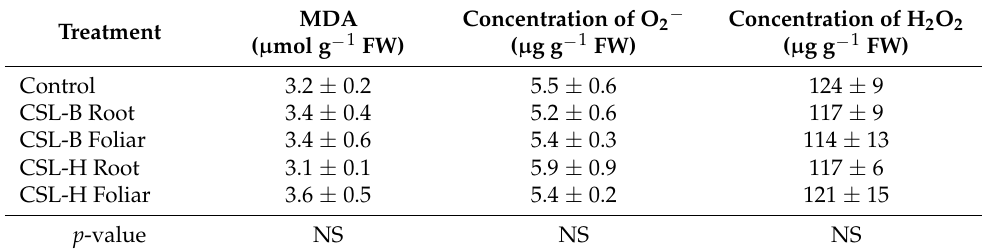
Table 4. Oxidative stress indicators, 7 days after the last application of the treatments.